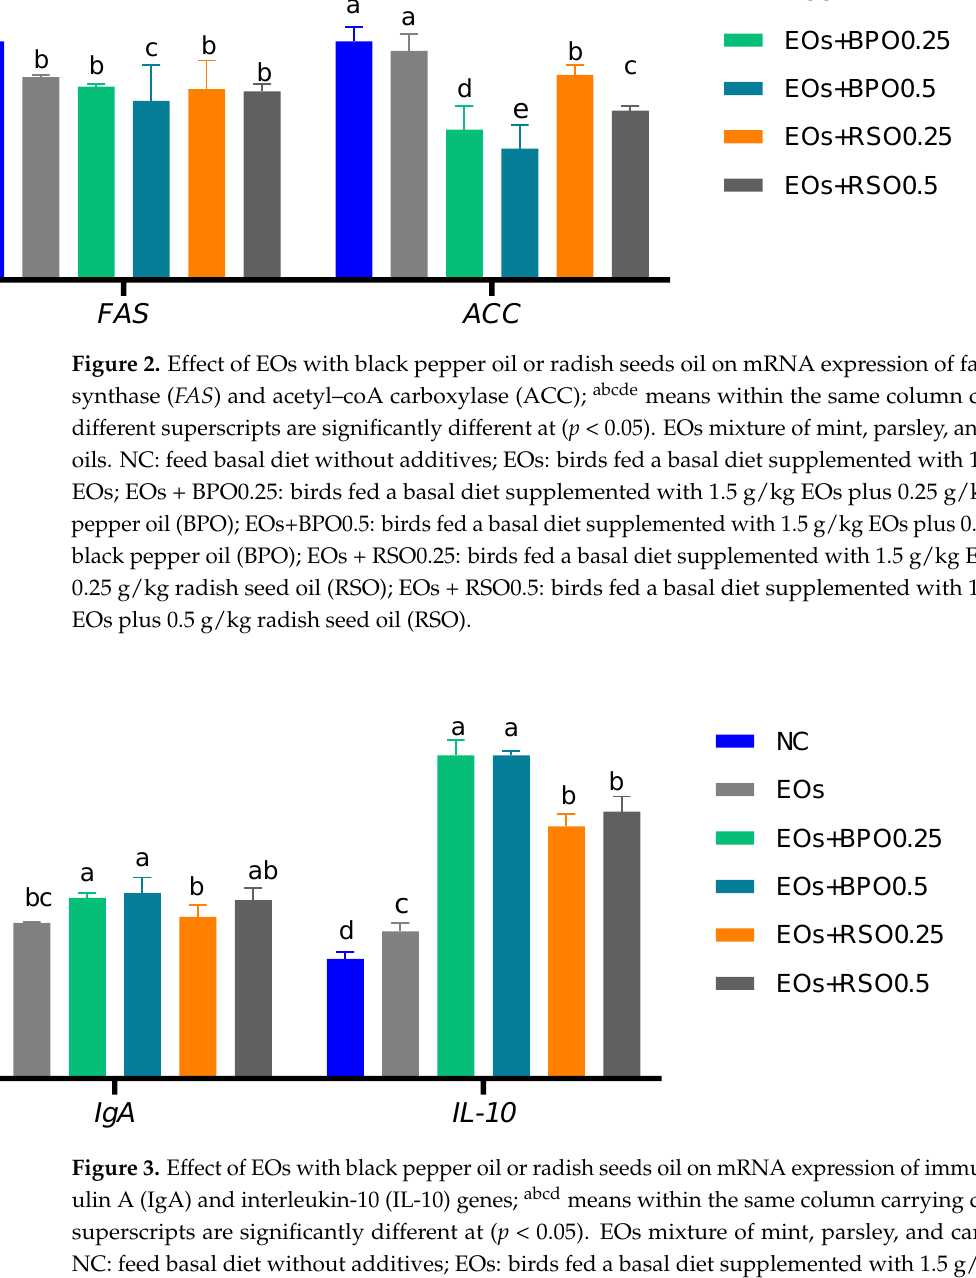
Figure 3. Effect of EOs with black pepper oil or radish seeds oil on mRNA expression of immunoglob- ulin A (IgA) and interleukin-10 (IL-10) genes; abcd means within the same column carrying different superscripts are significantly different at ( p < 0.05). EOs mixture of mint, parsley, and carrot oils. NC: feed basal diet without additives; EOs: birds fed a basal diet supplemented with 1.5 g/kg EOs; EOs + BPO0.25: birds fed a basal diet supplemented with 1.5 g/kg EOs plus 0.25 g/kg black pepper oil (BPO); EOs + BPO0.5: birds fed a basal diet supplemented with 1.5 g/kg EOs plus 0.25 g/kg black pepper oil (BPO); EOs + RSO0.25: birds fed a basal diet supplemented with 1.5 g/kg EOs plus 0.25 g/kg radish seed oil (RSO); EOs + RSO0.5: birds fed a basal diet supplemented with 1.5 g/kg EOs plus 0.5 g/kg radish seed oil